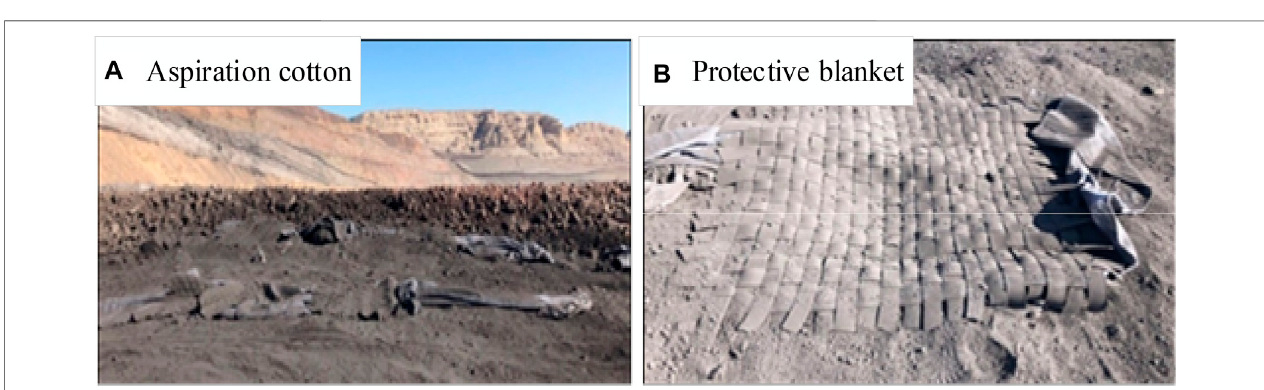
FIGURE 18 | Site map of test area after blasting. (A) Aspiration cotton. (B) Protective blanket.